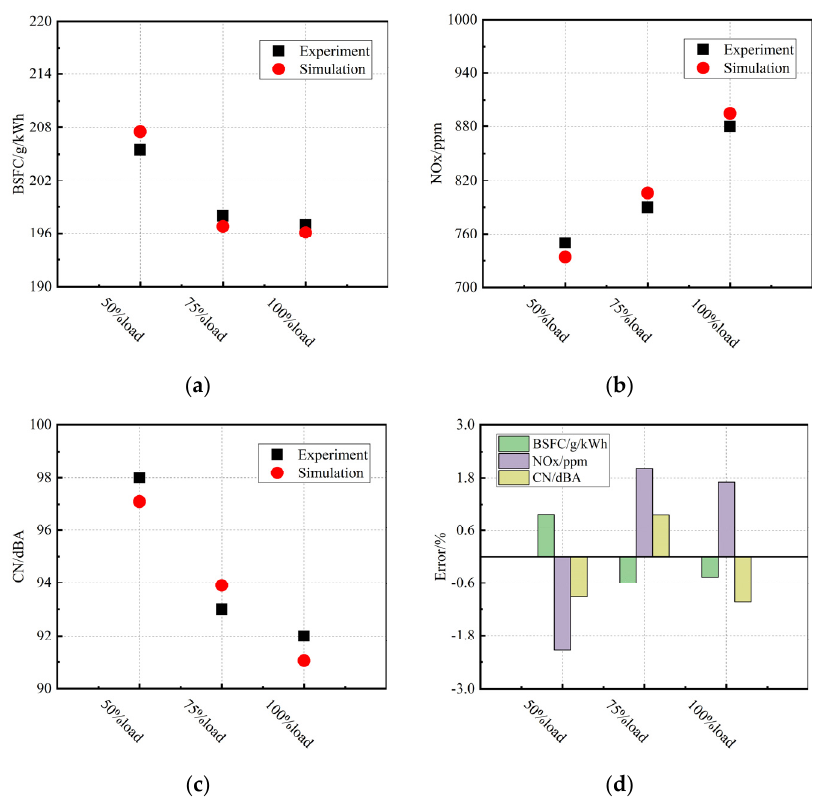
Figure 6. Comparisons between experimental and GT simulation results of BSFC, NOx and CN: ( a ) BSFC; ( b ) NOx; ( c ) CN; ( d )